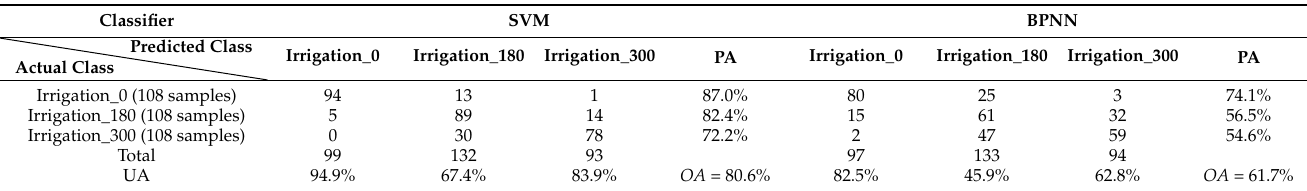
Table 10. Confusion matrix of the classification results of the irrigation